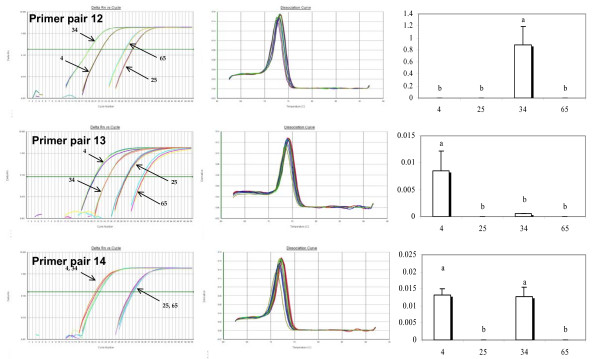
Outcomes of level of cDNA expression across families for primers (12, 13, 14) technically validated through the analysis of the melting curve of the EST [AJ565694]. From left to right: Plot of PCR cycle number against logarithm PCR product amount; Derivative Melting Curve; Statistical results of level of cDNA expression across families based on a multiple comparison test (Tukey). Family numbers are reported on the horizontal axis, histograms sharing a letter are not significantly different (P < 0.05).